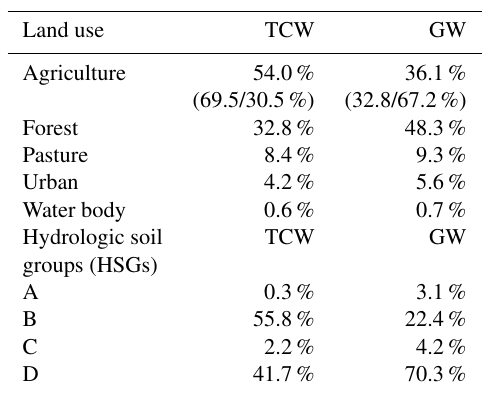
Table 1. Soil properties and land use distribution of the Tuck- ahoe Creek Watershed (TCW) and Greensboro Watershed (GW) (adapted from Lee et al.,